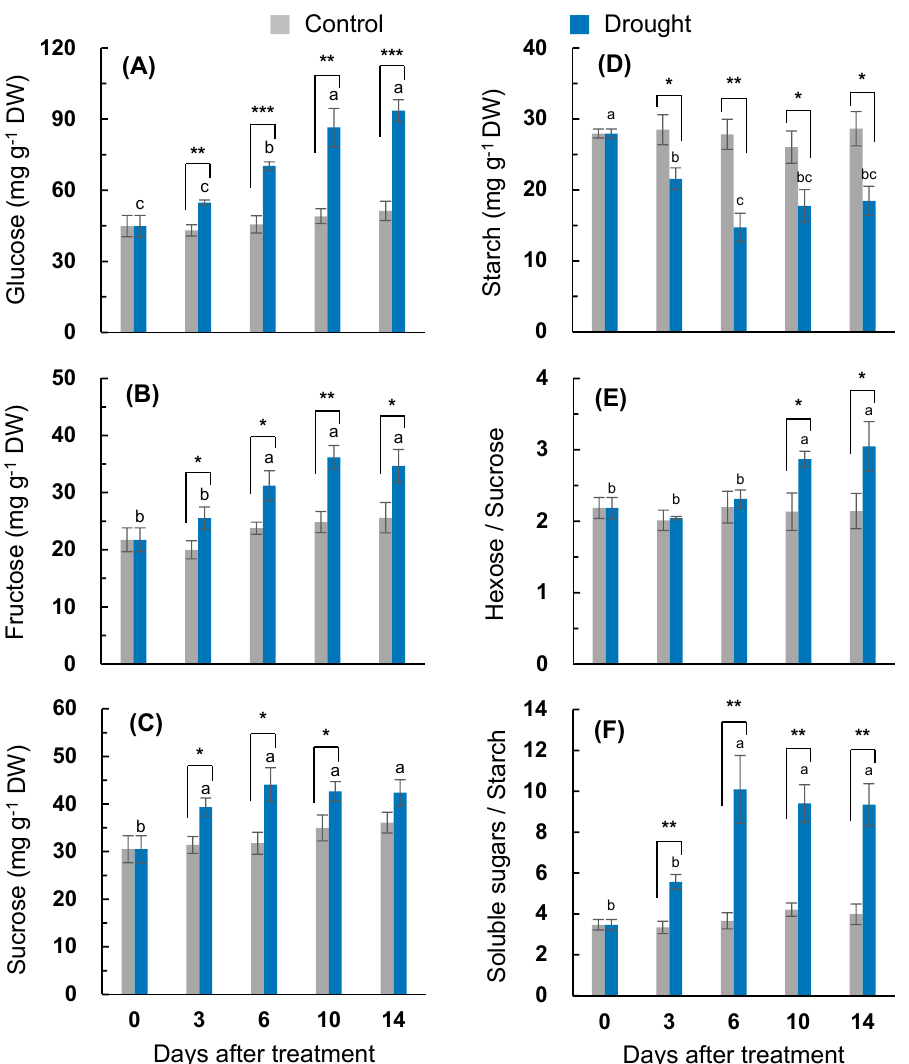
Figure 4. Changes in the ( A ) glucose, ( B ) fructose, ( C ) sucrose, ( D ) starch content, ( E ) hexose/sucrose ratio, and ( F ) soluble sugar/starch ratio in the leaves of the well-watered control or drought-stressed plants during 14 days of treatment. Data are presented as the mean ± SE for n = 4. Bars labeled with different letters in the drought-stressed plants are significantly different at p < 0.05, according to Duncan’s multiple range test. Asterisks denote a statistical difference between the drought treatment and control: * p < 0.05, ** p < 0.01, and *** p < 0.001.